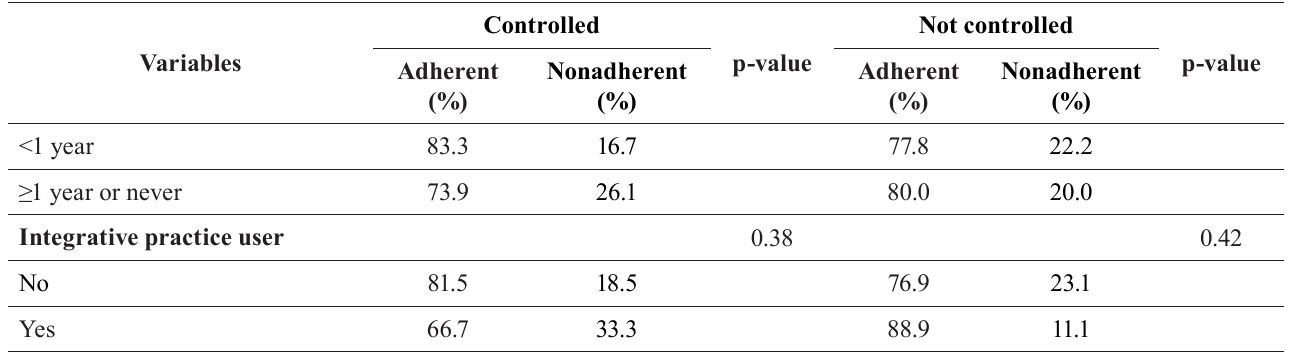
TABLE II - Prevalence of self-reported drug adherence in industry workers with controlled and uncontrolled hypertension and/ or diabetes mellitus, 2017 to